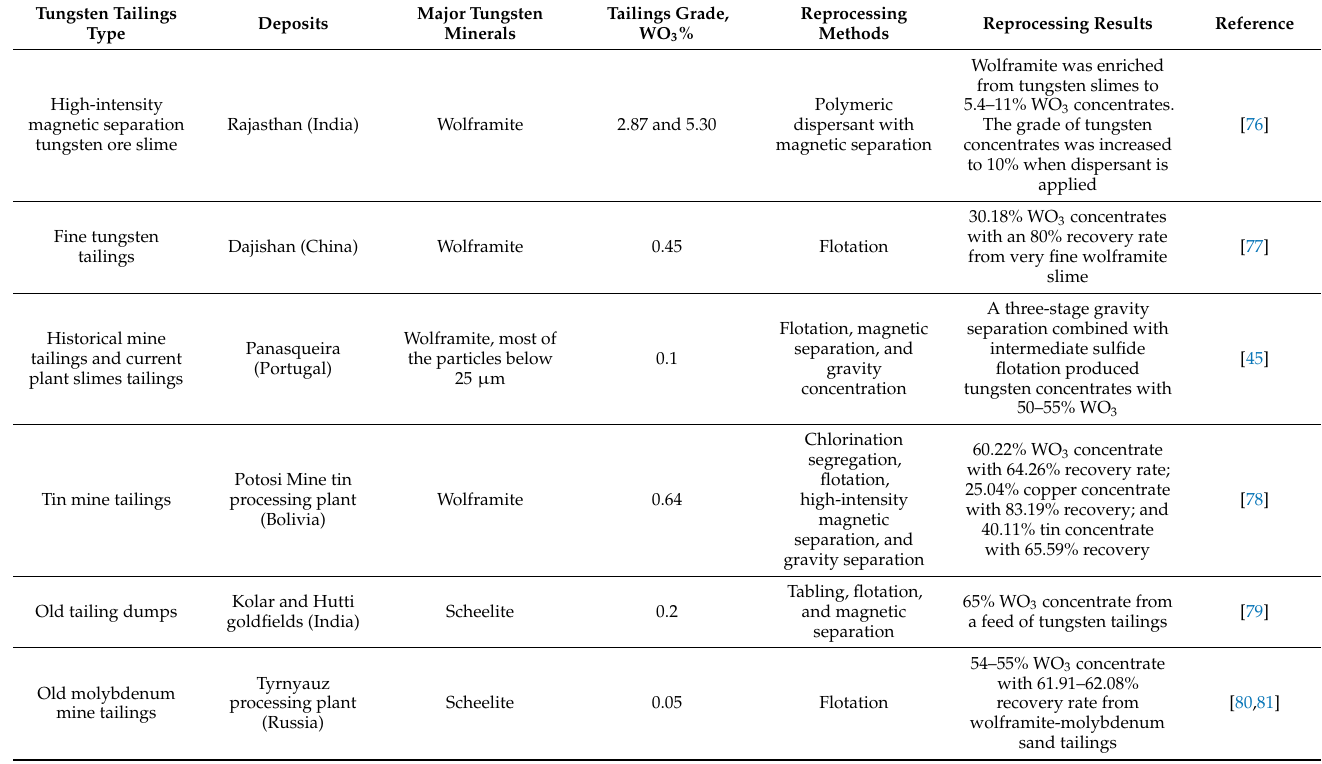
Table 6. Worldwide reprocessing trials for tungsten recovery from